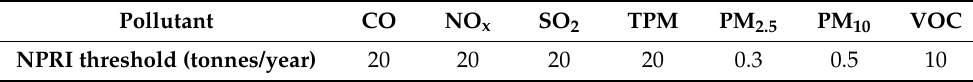
Table 1. NPRI reporting thresholds for 2020 to 2021 (retrieved from [17]). Pollutant CO NO x SO 2